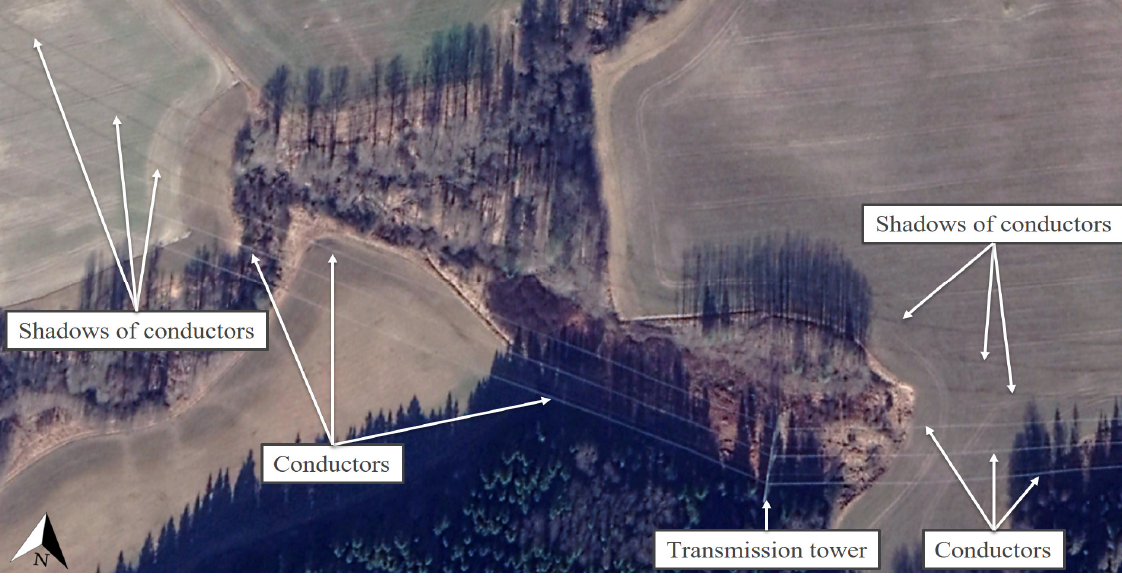
Figure 5. The shading characteristics of high-voltage transmission tower and its conductors in Botkyrka, Sweden, on 19 March 2020 at approximately 1:00 p.m. (local time), based on [41].